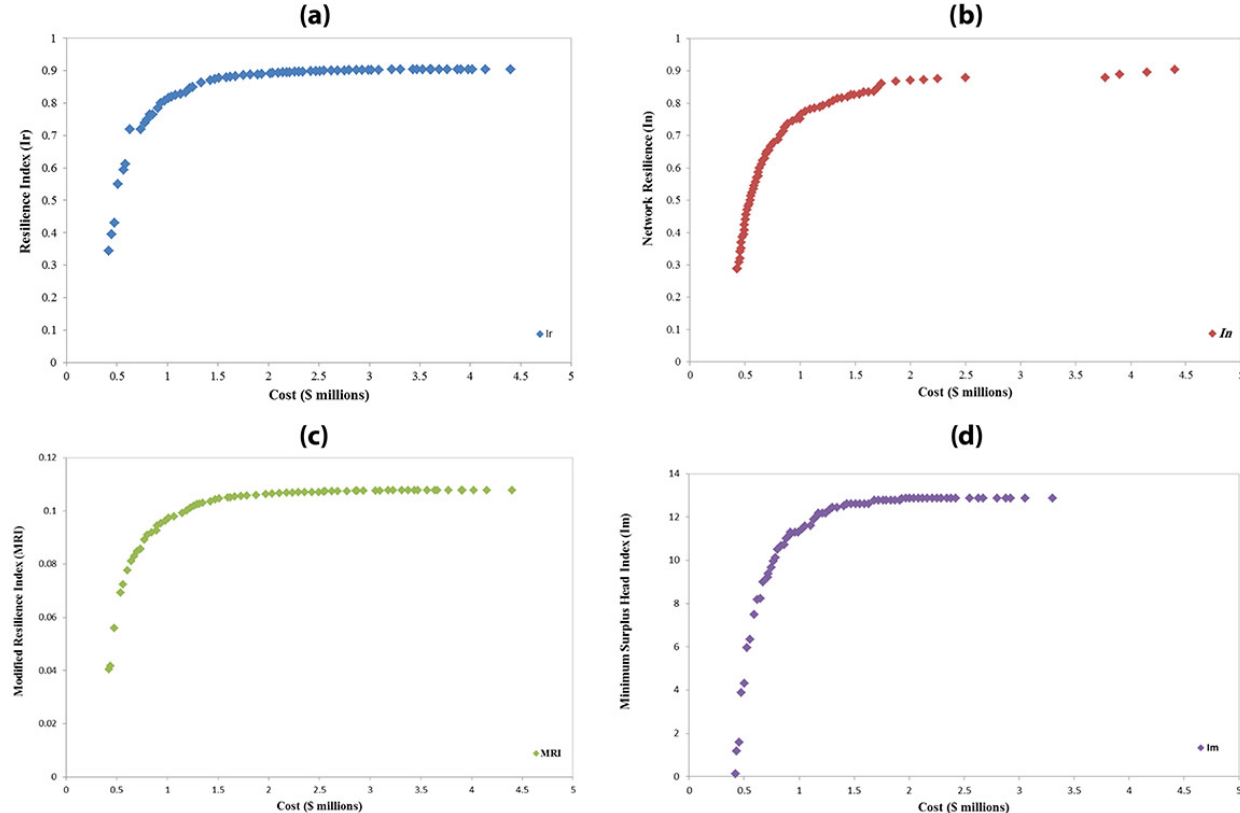
Figure 1. Pareto front of two-objective function optimization of the two-loop network: (a) cost- I r , (b) cost- I n , (c) cost-MRI, (d) cost- I m .